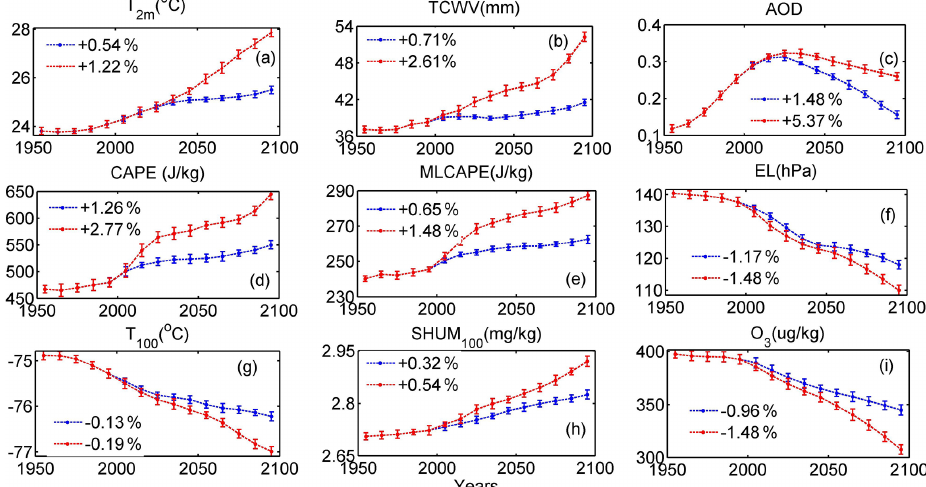
Figure 6. The 150-year multi-model India-wide average projections of various parameters using the RCP2.6 (blue) and RCP8.5 (red) sce- narios for (a) the 2m temperature, (b) TCWV, (c) AOD, (d) CAPE, (e) MLCAPE, (f) EL, (g) the temperature at 100hPa, (h) the specific humidity and (i) the ozone mixing ratio at the same level. Legends indicate the 5-yearly linear significant trends in these